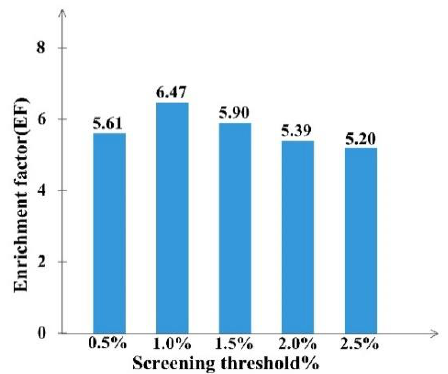
Figure 2. The enrichment factor (EF) at screening threshold of 0.5–2.5% for RLPH screening.